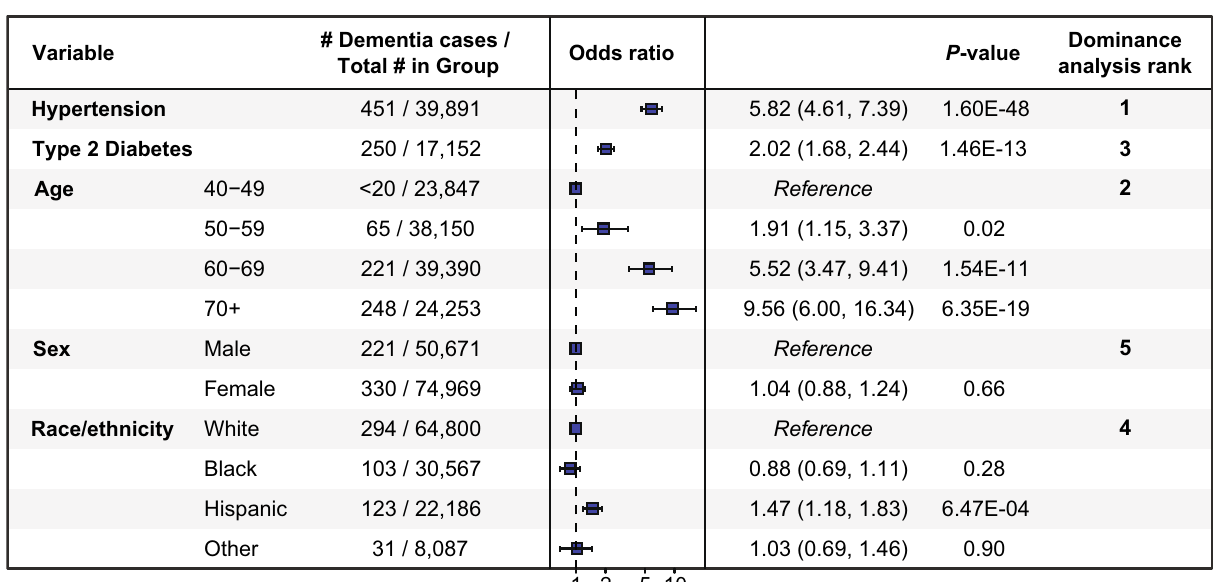
Figure 4. Modeling dementia status using hypertension, T2D, age, sex, and SIRE. Forest plot with the odds ratios and 95% confidence interval along with statistical significance for each of the predictor variables used to model dementia (outcome) status. The last column shows the relative importance of the variables obtained using dominance analysis. The logistic regression model specification is shown above the figure and the AUC score for the model is reported under the formulation of the